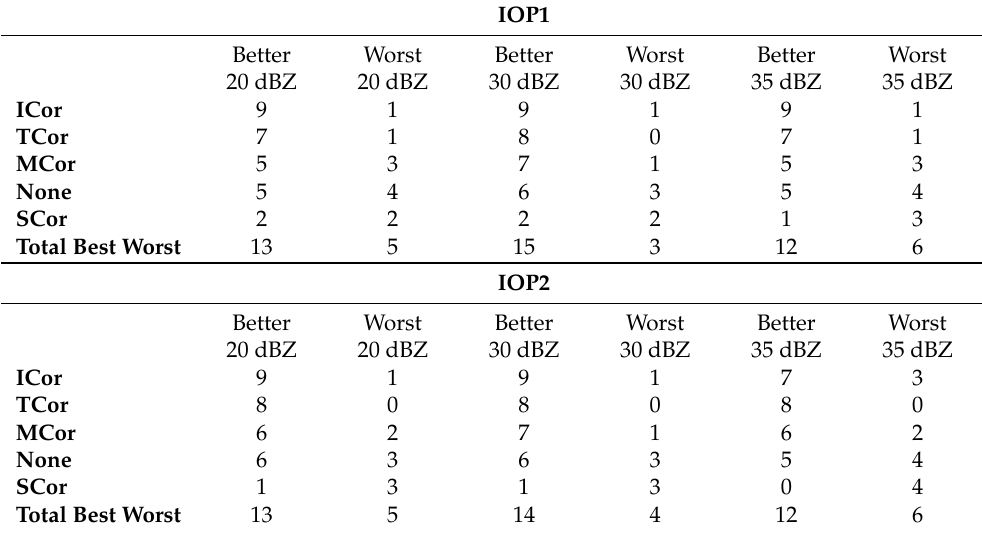
Table 1. Number of associations of each method related to the best and worst combinations with respect to the algorithm without corrections in the displacement vector (None) for each thresh- old